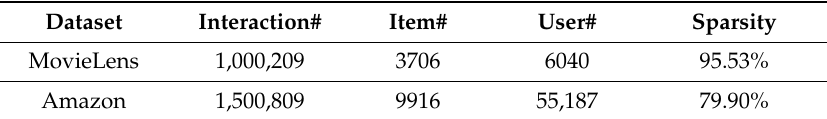
Table 2. Evaluation